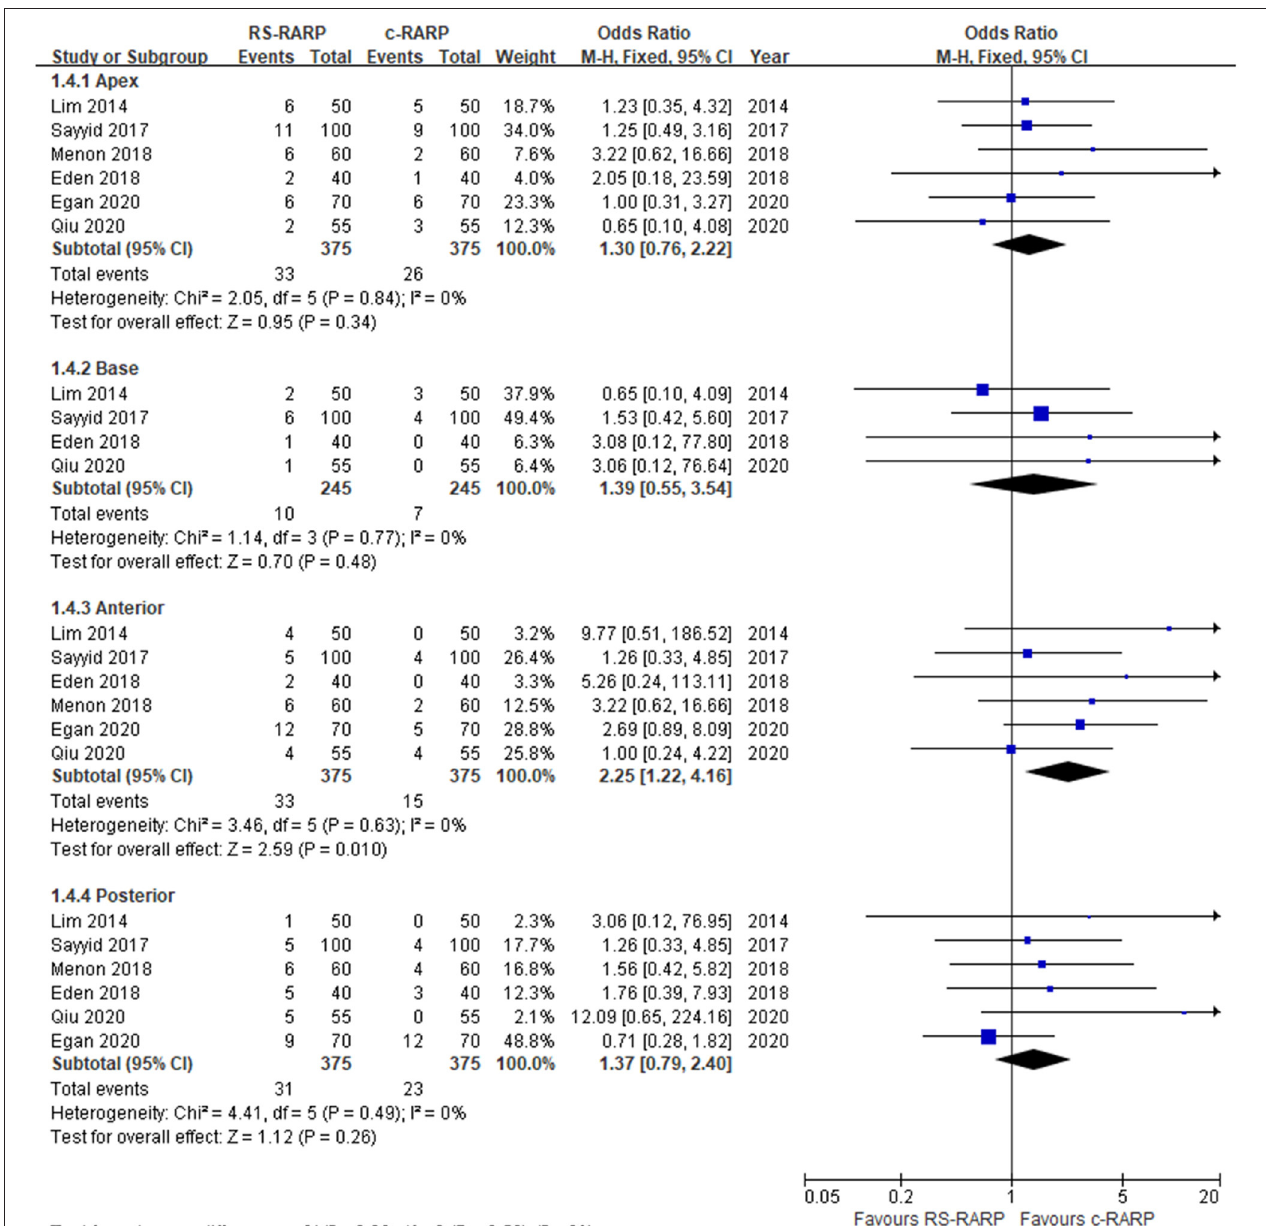
FIGURE 6 | Forest plot of location of positive